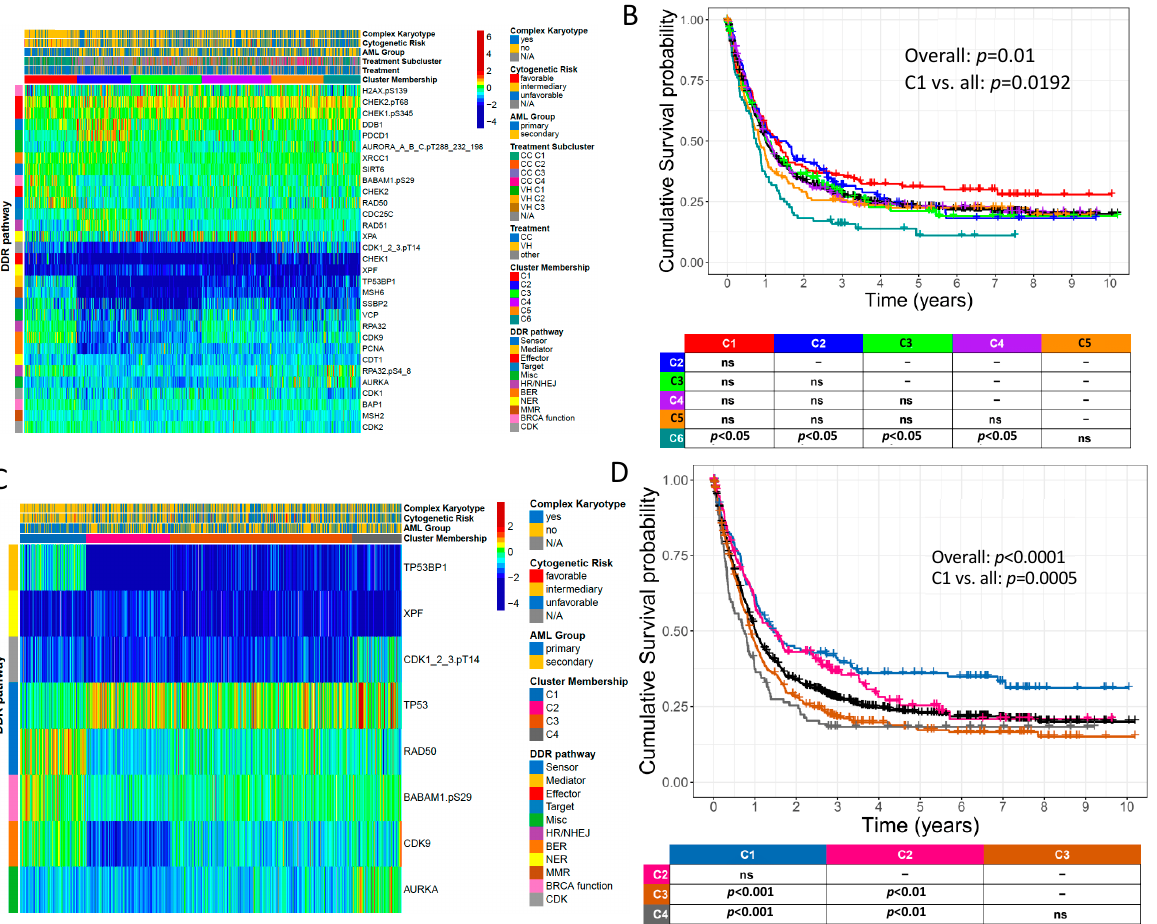
Figure 4. Novel DDR-related protein groupings are prognostic for overall survival. The core set of 21 DDR proteins was combined with 10 additional DDR-related proteins that have been previously cited in the literature to define an expanded array of DDR+DDR-related proteins (ExpDDR). ( A ) These 31 proteins are delineated as rows in the heatmap (right side), where each protein also has an annotation for its relevant DDR pathway (left side). The top of the heatmap depicts 6 unique clusters of patients with distinct proteomic profiles. Annotations including cytogenetic risk group and com- plex karyotype are also included at the top of the heatmap. The heatmap itself displays the expres- sion levels of these DDR-related proteins in all patients. Proteins downregulated in expression rel- ative to normal CD34+ cells are colored in cooler colors approaching deep blue, while upregulated proteins are colored in warmer colors approaching burgundy. ( B ) The associated Kaplan–Meier OS curves ( n = 810) for each of the 6 identified patient clusters. Pairwise comparisons between the clus- ters are shown beneath the cumulative survival probability curves. ( C ) A subset of 8 maximally prognostic ExpDDR proteins identified four unique patient clusters with ( D ) associated survival curves ( n = 810). Pairwise cluster comparisons are depicted beneath the OS curves. ns = not signifi- cant. 2.6. DDR-Related Proteins Are Prognostic for OS in Patients Receiving Either Conventional Chemotherapy (CC) or Venetoclax plus Hypomethylating Agent (HMA) Therapy (VH) Recently, the choice of AML therapy in adults has divided into a decision between CC (most commonly cytosine arabinoside and an anthracycline, often combined with other agents), or therapy with a BCL-2 inhibitor (typically venetoclax) combined with a HMA (decitabine, azacytidine) (VH). As these therapeutic strategies have different mech- anisms of action, we hypothesized that DDR and DDR-related proteins might be differen- tially prognostic of response to CC or VH. We first asked if individual proteins from the broader set of DDR and DDR-related proteins stratified OS in CC/VH patients by predefined divisions of expression: medians, thirds, quartiles, quintiles, and sextiles. This protein group contained those delineated in Figure 4A (ExpDDR) with the addition of TP53, CDKN1A, CDKN1B, CDKN1B.pS10, CDKN1B.pT198, and CDKN2A, to constitute a maximally expanded array of DDR and